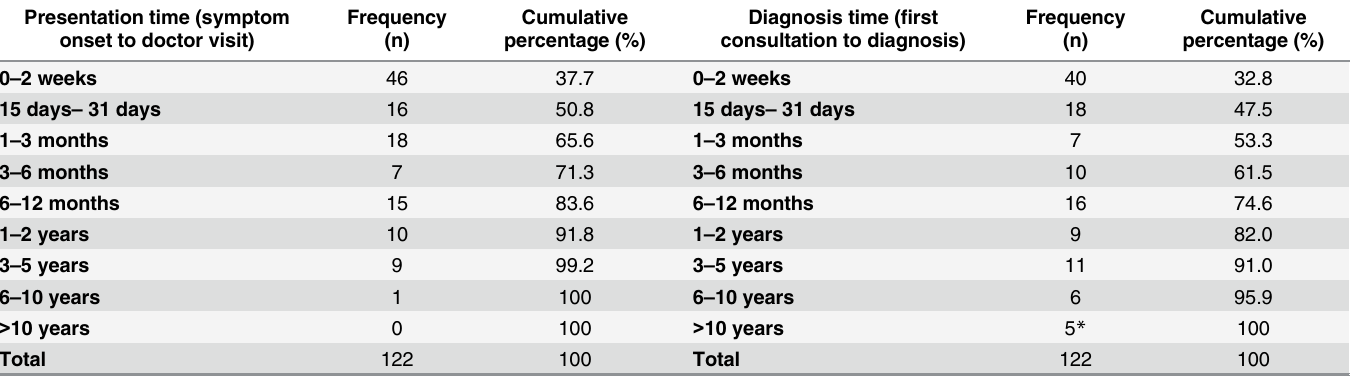
Table 3. Frequencies and cumulative percentages of presentation time and diagnosis time for participants in this sample.